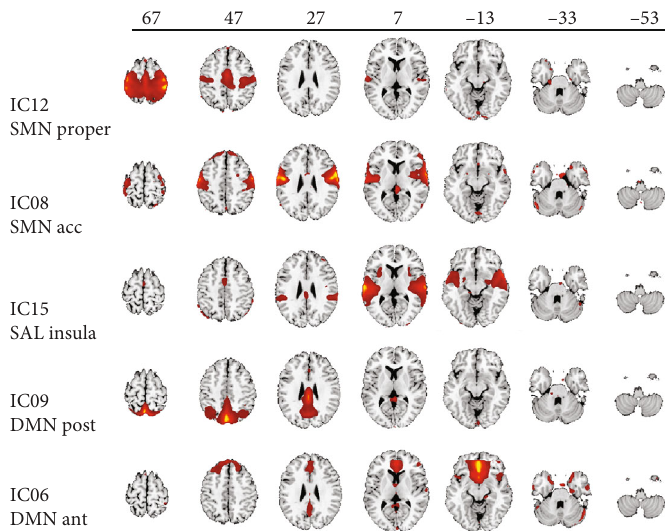
Figure 1: Spatial maps of independent components displayed on a T1 template. The top row gives the z -scale in mm MNI space. DMN ant: anterior part of default mode network; DMN post: posterior parts of default mode network; IC: independent component; SMN acc: accessory sensorimotor network; SMN proper: proper sensorimotor network; SAL insula: saliency network.